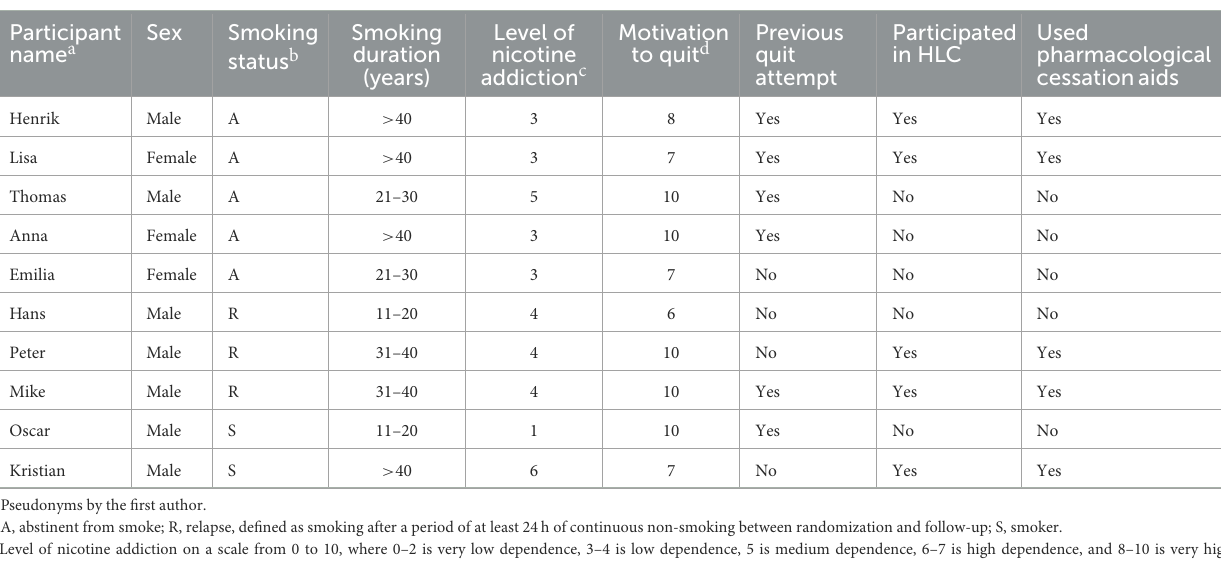
TABLE 2 Patient characteristics.